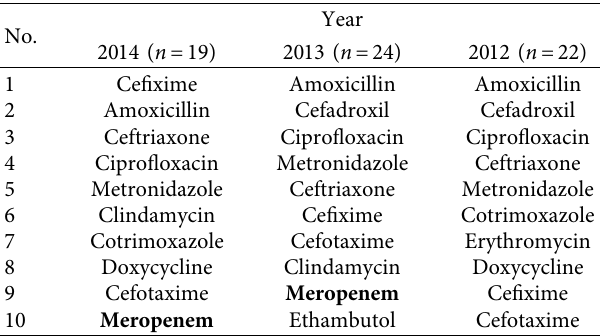
Table 1: The ranking of 10 antimicrobials mostly commonly used in hospitals (16 districts of 8